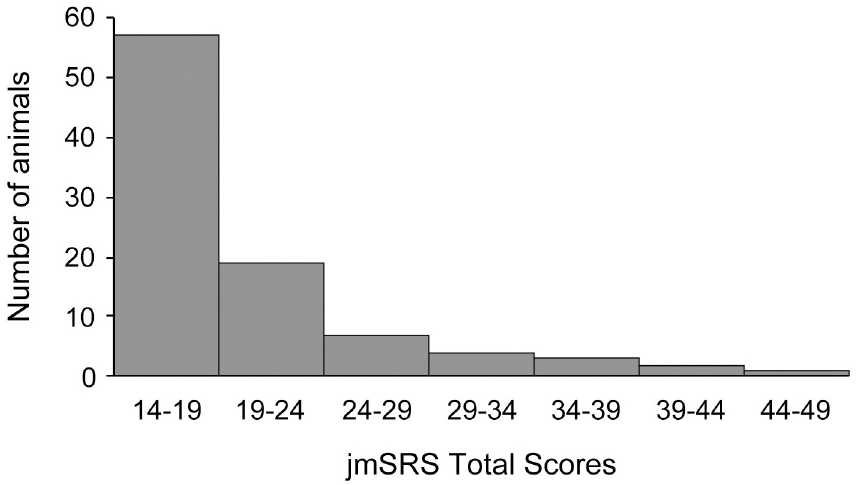
Fig 1. Histogram showing data frequency distribution of the jmSRS total scores in our juvenile macaque population. The jmSRS total score was calculated for each subject as the sum of scores for each jmSRS item. Each column represents the number of animals with the jmSRS total score indicated on the X-axis.